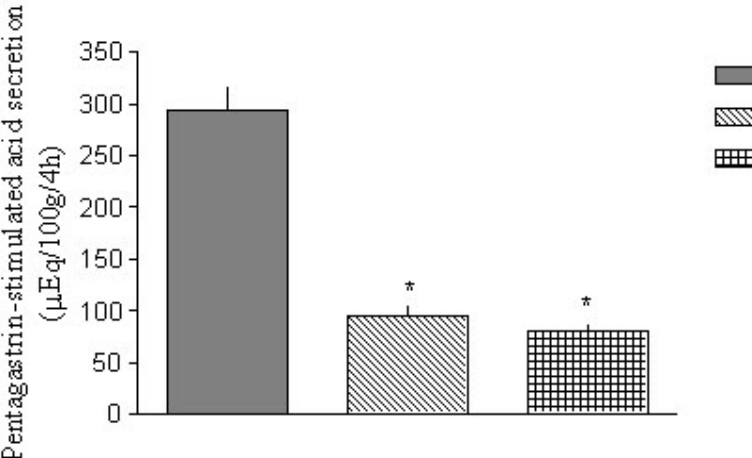
FIGURE 2. Effect of gamma irradiation on pentagastrin (150 μ g/kg)-stimulated gastric acid secretion in the 4-h pylorus-ligated rat. Rats were subjected to 3- or 6-Gy gamma irradiation and 7 days later subjected to pylorus ligation and s.c. pentagastrin together with i.g. 2 ml of physiological saline for 4 h. * p < 0.05 vs. control (unirradiated group).